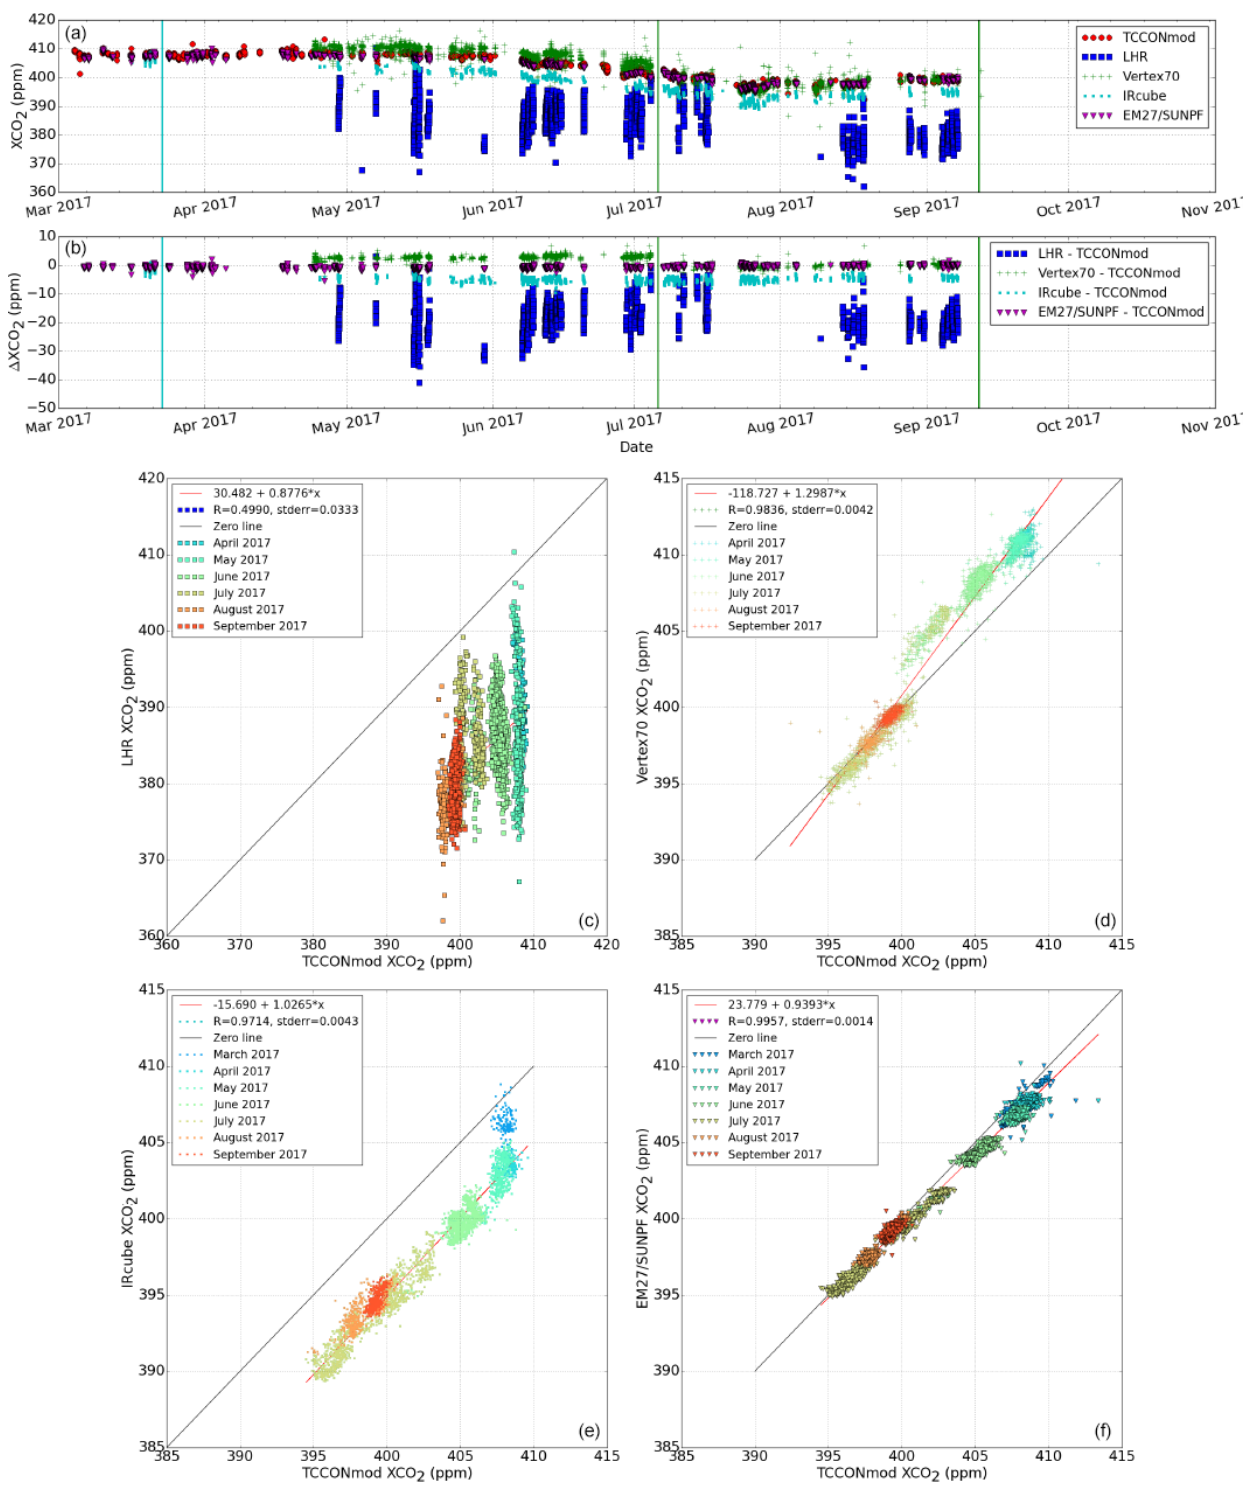
Figure 7. Time series of XCO 2 retrievals for TCCONmod, LHR, Vertex70, IRcube, and EM27/SUN using the standard procedure with the TCCON a priori for measurements performed at Sodankylä in 2017 (a) . The difference of XCO 2 time series for each instrument relative to the reference TCCONmod results (b) . The correlation plots of XCO 2 from LHR, Vertex70, IRcube, and EM27/SUN instruments vs. TCCONmod for all measurements with SZA < 75 ◦ : (c) LHR vs. TCCONmod; (d) Vertex70 vs. TCCONmod; (e) IRcube vs. TCCONmod; (f) EM27/SUN vs. TCCONmod. The colours represent the measurements performed during the different months of the